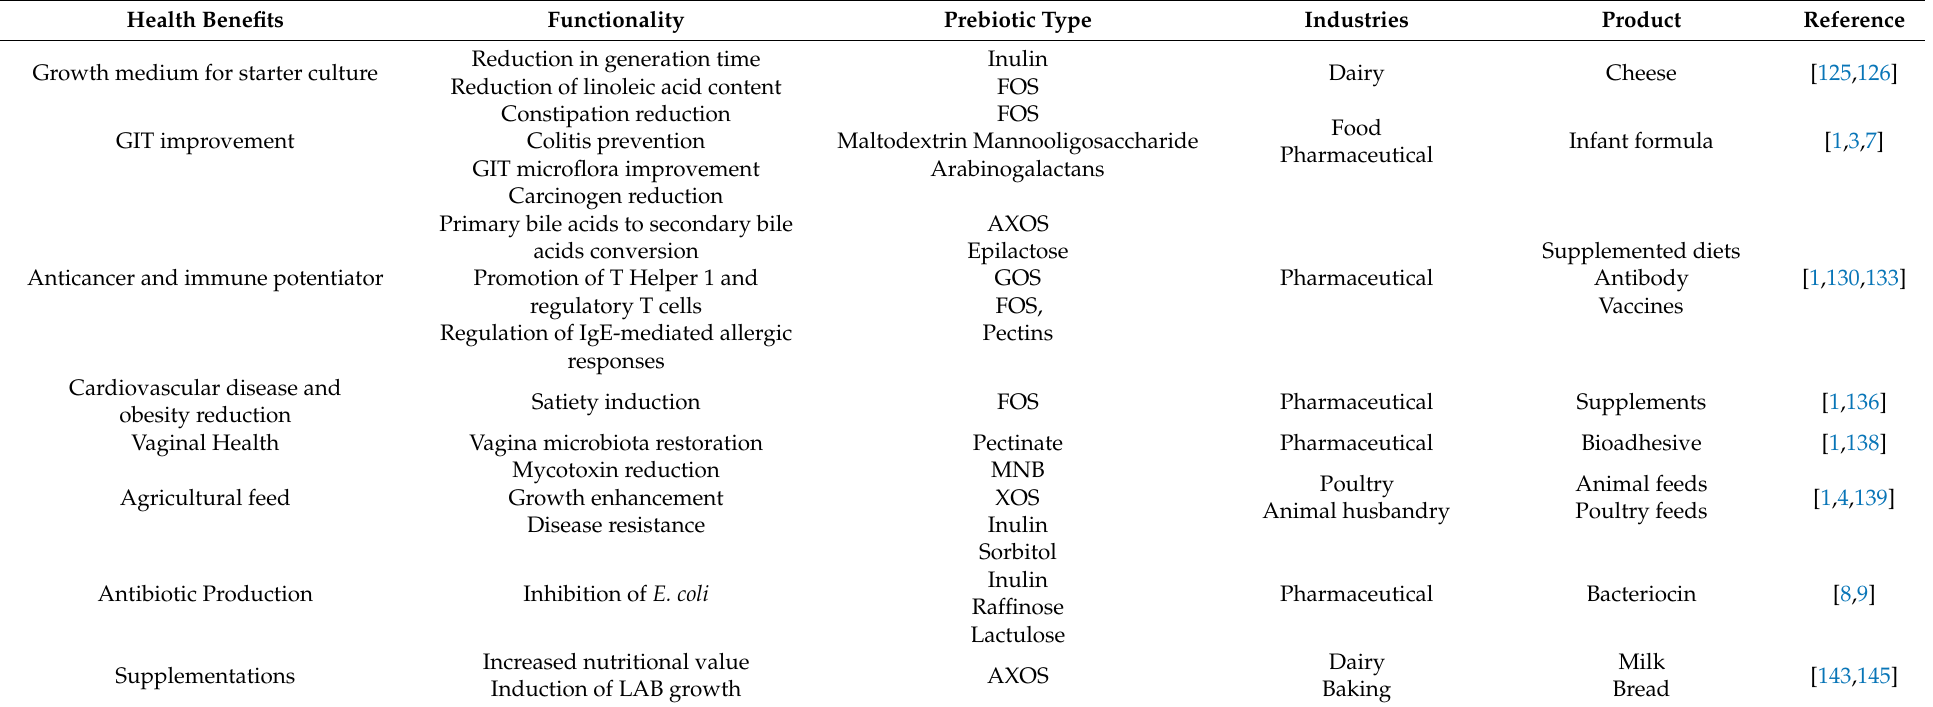
Table 3. Prebiotics and their health benefits in various